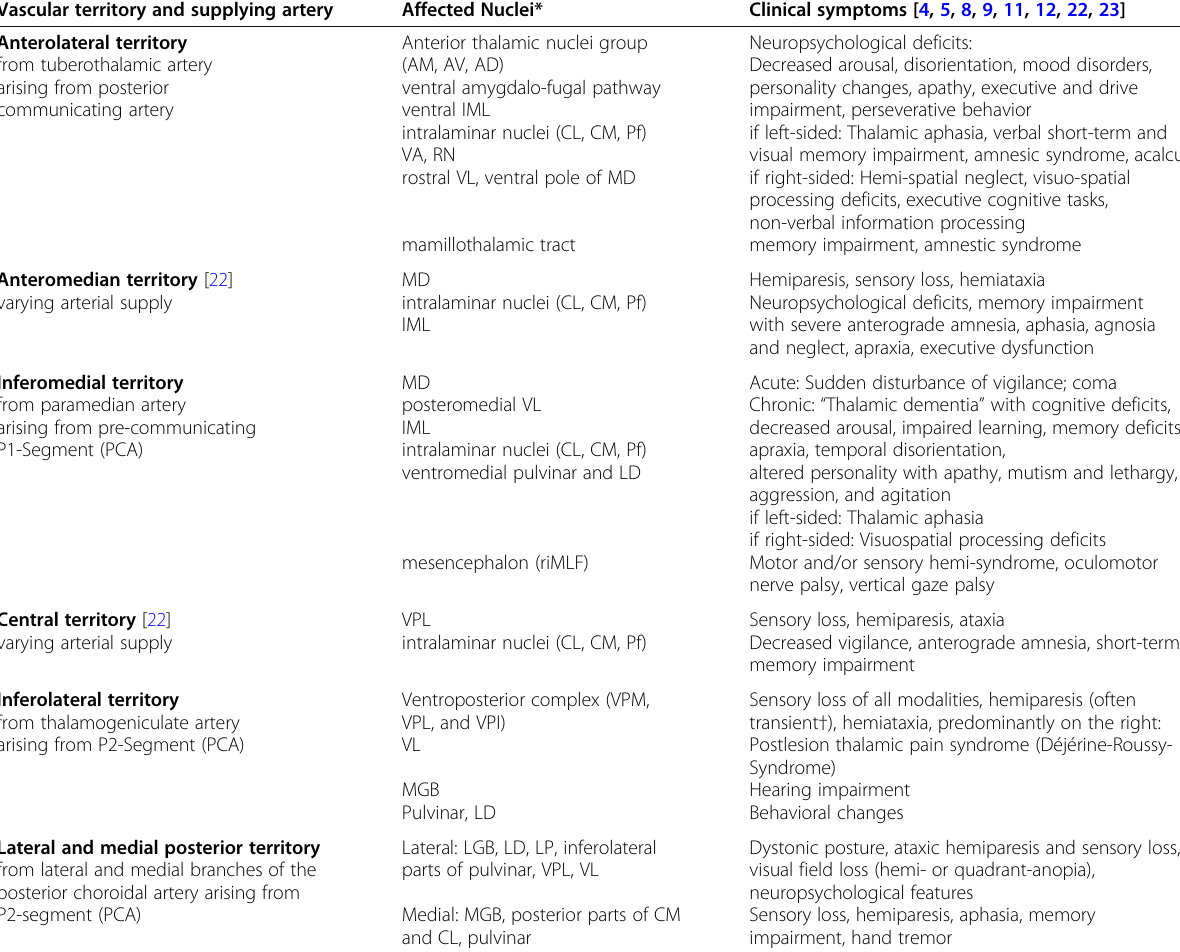
Neuropsychological deficits: Decreased arousal, disorientation, mood disorders, personality changes, apathy, executive and drive impairment, perseverative behavior non-verbal information processing memory impairment, amnestic syndrome